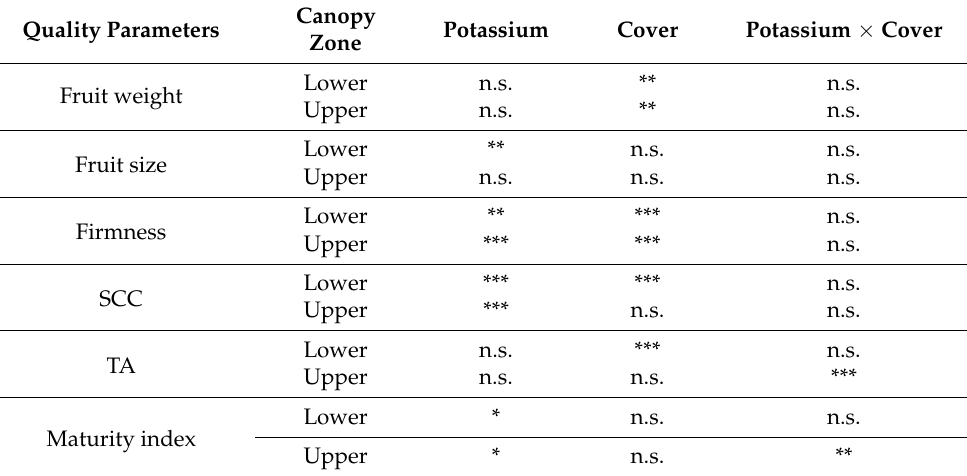
Table 2. The statistical significance of each factor and their interaction with the analysis of fruit quality. Abbreviations: SSC (soluble solid content); TA (titratable